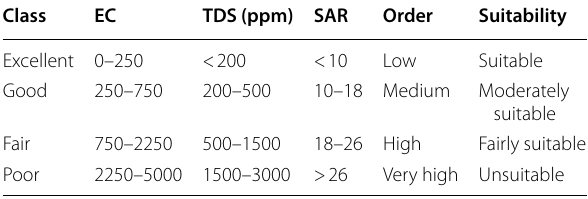
their calculated RSC values.